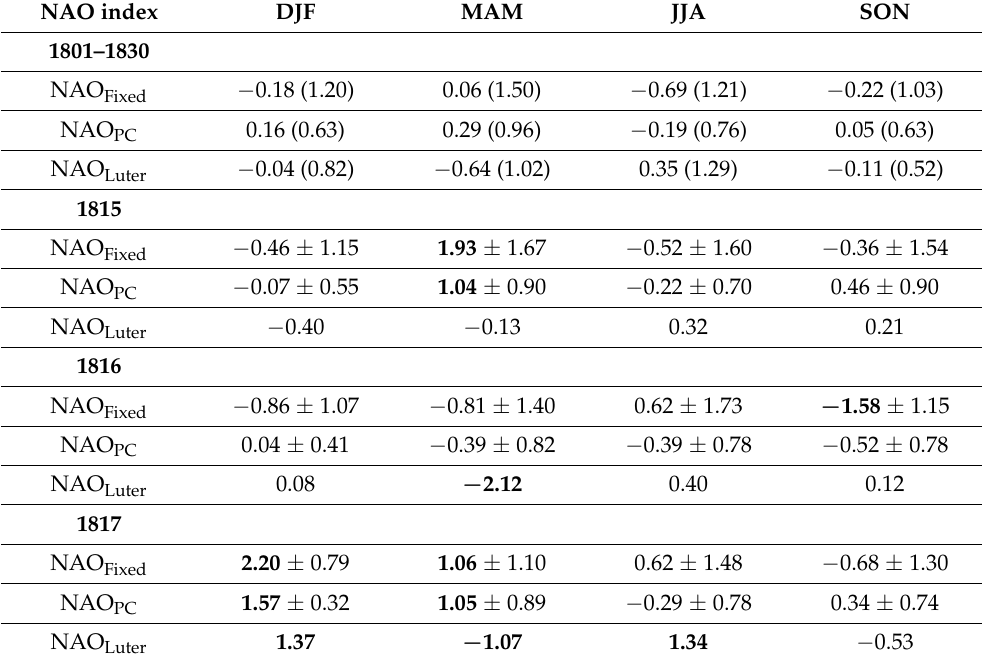
Table 7. Summary statistics: (top) EKF400v2 ensemble means with interannual standard deviations of these means in brackets for 1800–1830; (lower) 1815–1817 annual seasonal values of respective NAO indices with ± values for NAO Fixed and NAO PC expressing ensemble standard deviation of